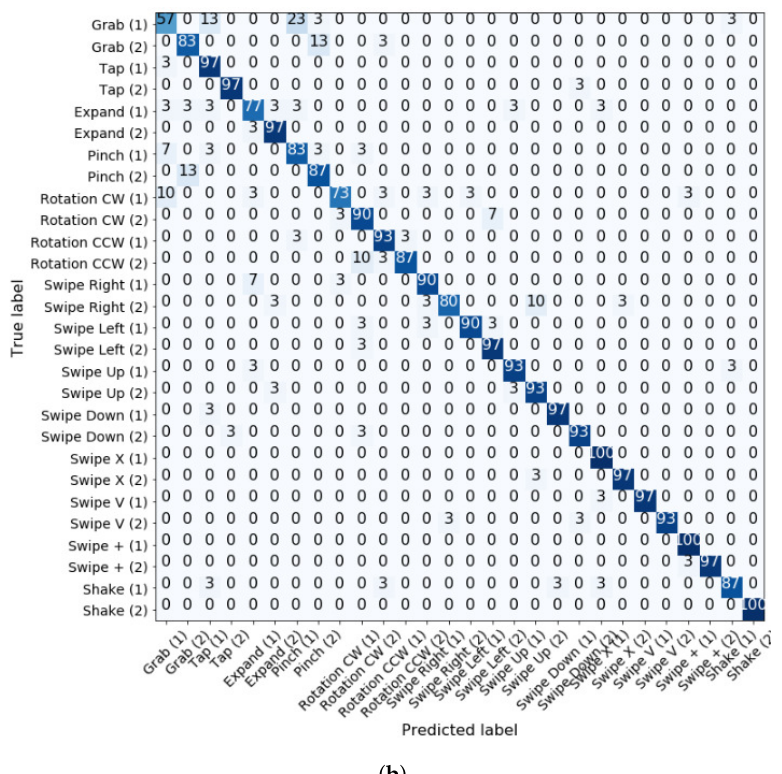
Figure 15. Confusion matrix of the best prediction results on the skeleton data: MLF LSTM Con1-2D with skeleton data (accuracy of 93.69%) ( a ) on DHG-14 and MLF LSTM Conv1-2D with skeleton data (accuracy of 90.11%) ( b ) on DHG-28.